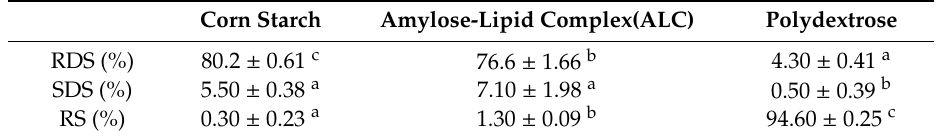
Table 4. Percentages of RDS, SDS, and RS in corn starch and the amylose-lipid complex. Corn